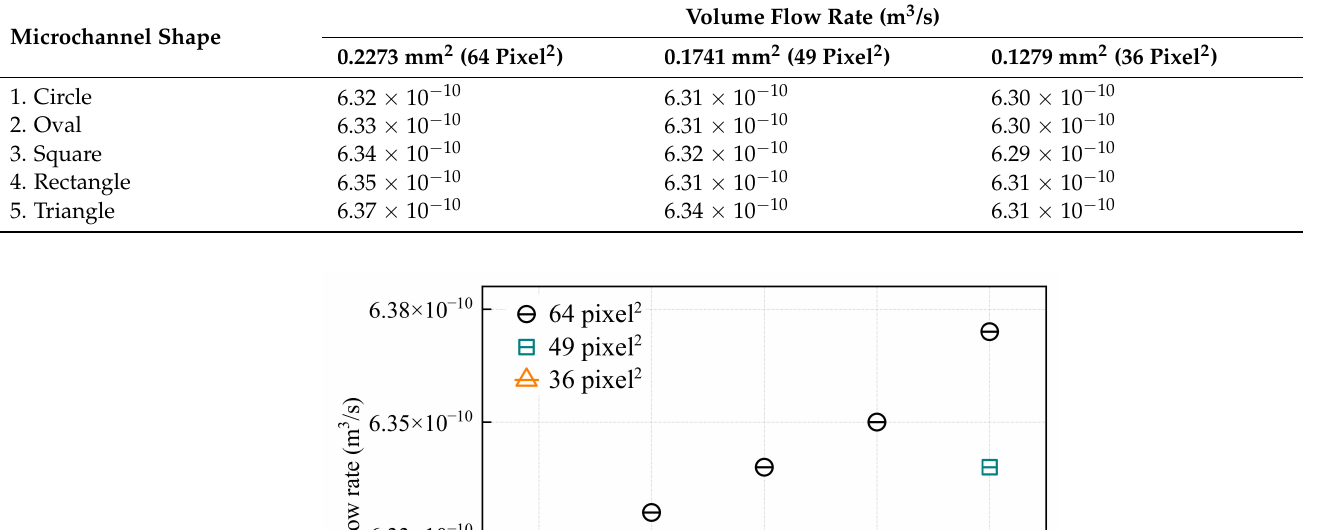
Table 8. Volume flow rate through a cement–rock sample: effect of variable microchannel shape and the size of the cross-sectional area.